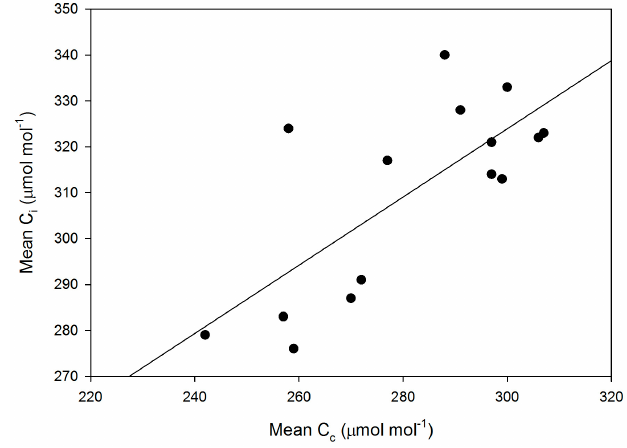
Figure 6. CO 2 assimilation rate (A) as a function of sub-stomatal CO 2 concentration (C i ) for all measurements made on leaves of fifteen cultivars of soybean. The equation A = − 125.6 + 26.7 ln(C i ) had an r 2 value of 0.645. Plants 2016 , 5 , 44